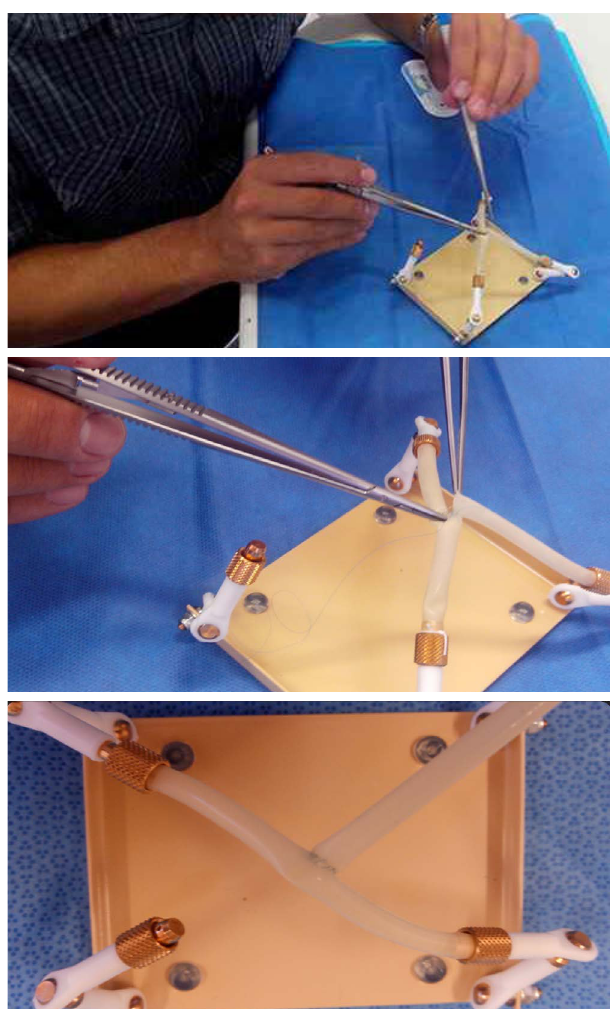
Fig. 4 - Arroyo simulator for individual coronary anastomosis training. Resident training of coronary anastomosis with individual Arroyo anastomosis